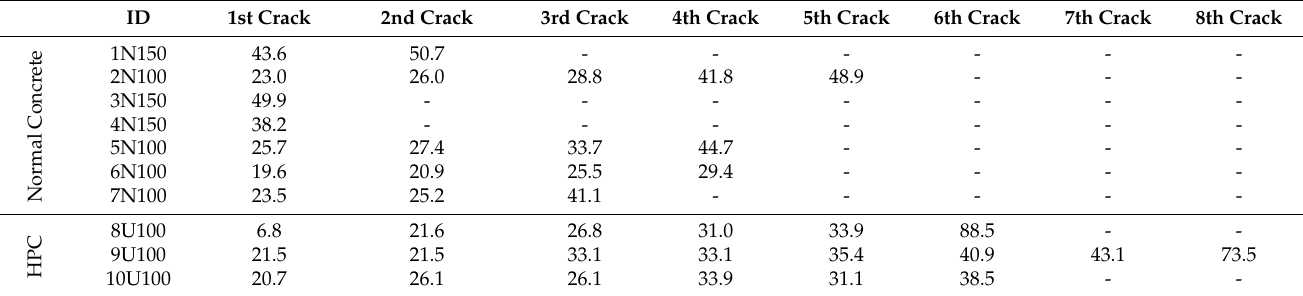
Table 4. Cracking loads registered in the data acquisition system for all specimens.